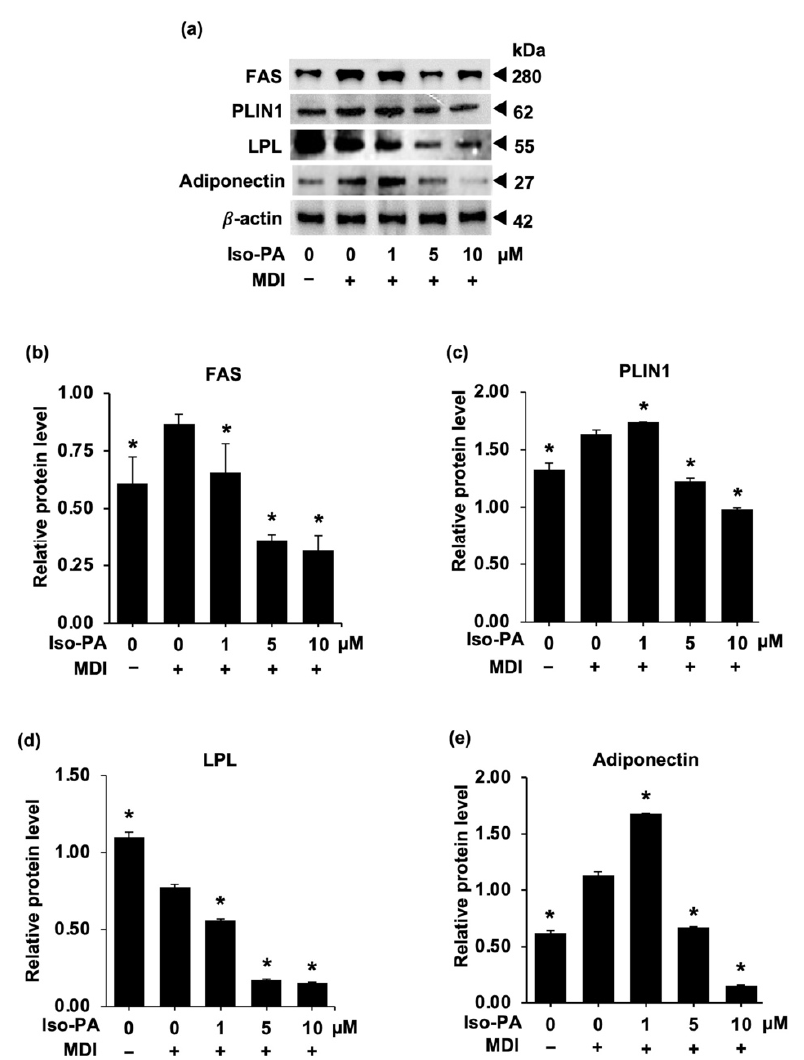
Figure 2. Inhibitory effects of isopanduratin A on the expression of adipogenic effectors in 3T3-L1 adipocytes. Cells were differentiated for 8 days in differentiation medium containing isopanduratin A at non-toxic concentrations. ( a ) Protein expression was then examined by Western blotting. The expression levels of ( b ) FAS, ( c ) PLIN1, ( d ) LPL, and ( e ) adiponectin relative to β -actin were measured by the ImageJ program. Confluent 3T3-L1 cells were cultured in the presence (+) or absence ( − ) of differentiation medium (MDI) with 0–10 μ M isopanduratin A (Iso-PA). Cells treated with 0.5% v / v DMSO functioned as untreated control (0). Bar graphs demonstrating mean ± SD (n = 3) were created using GraphPad Prism. A one-way ANOVA with Tukey’s post hoc test was used to compare the means of treatment and the differentiated control groups (* p < 0.05) .